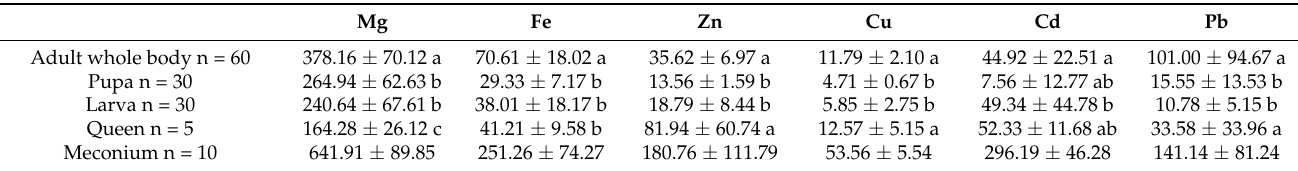
Table 2. Element concentrations in the different developmental stages of the European hornet ( V. crabro ). Data are reported as mean ± standard deviation (SD), and are expressed in µ g/g wet weight (ww) for Mg, Fe, Zn and Cu and in ng/g (ww) for Cd and Pb. For each metal, different lower cases indicate significant differences. Mg Fe Zn Cu Cd